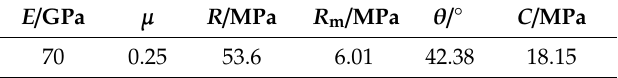
Table 4. Physical and mechanical parameters of the specimens.